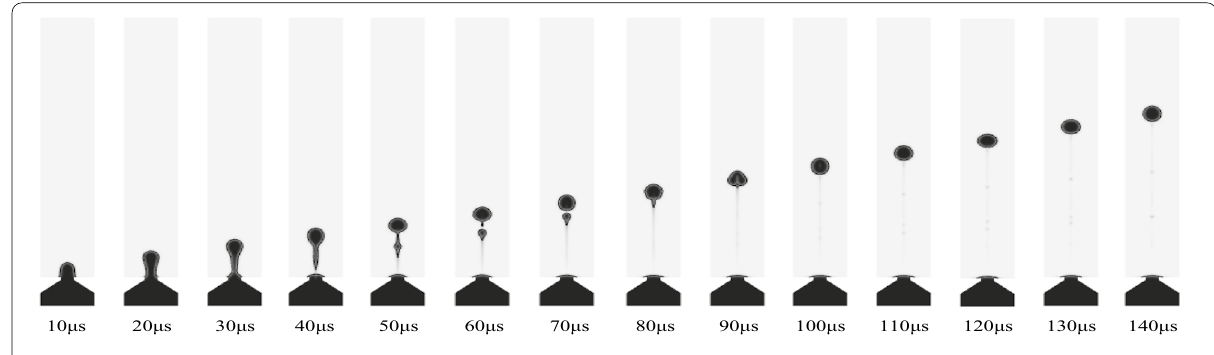
Figure 8 Process of droplet